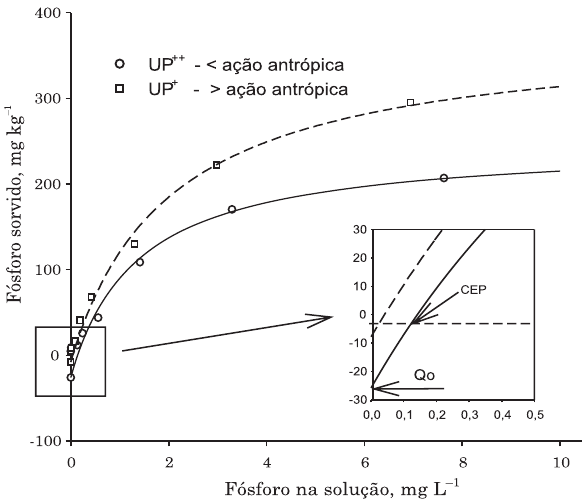
Figura 2. Relação entre o fósforo sorvido e da solução em sedimento coletados em suspensão no escoamento superficial em duas unidades paisagísticas (UP), com diferentes graus de ação antrópica, de uma sub-bacia da pequena bacia hidrográfica do Arroio Lino, Agudo,